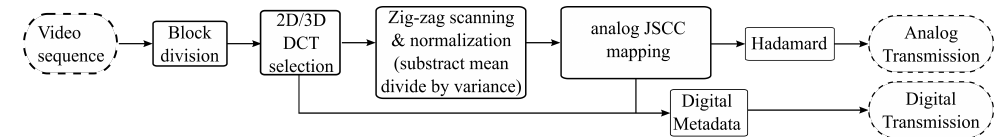
Figure 1. Block diagram of the JSCC-Cast encoder and